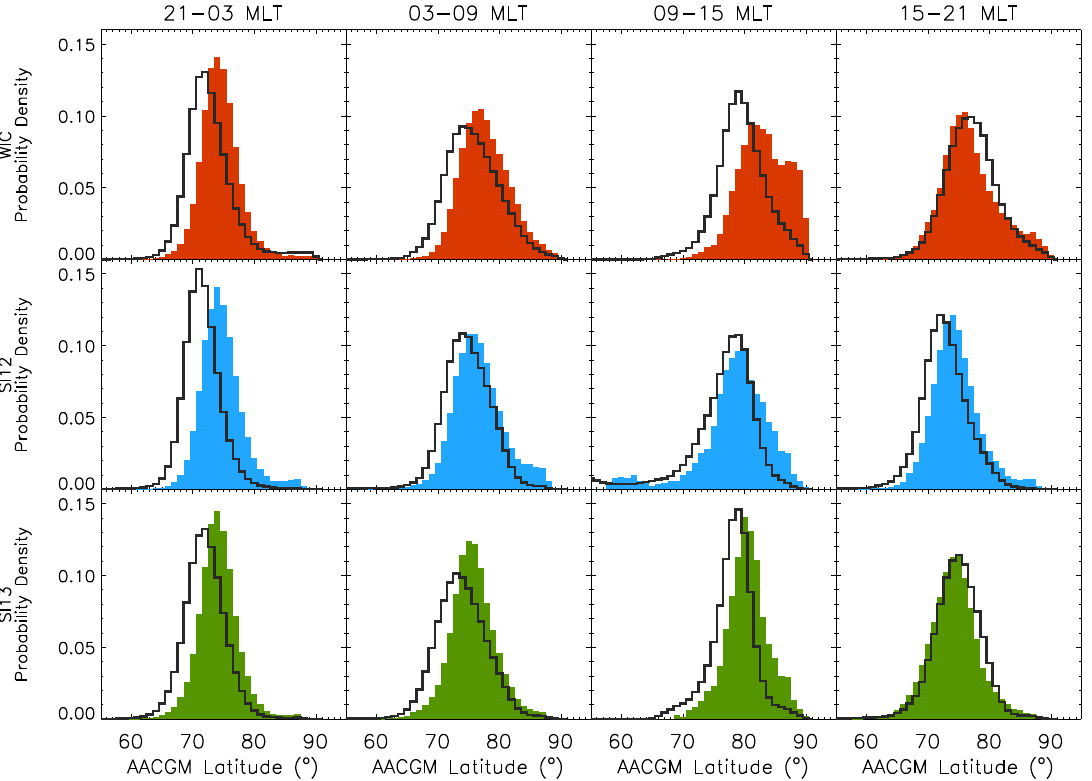
Fig. 6. Probability densities of IMAGE FUV PALBs derived using the method outlined in this paper during May 2000 to August 2002 with a resolution of 1 ◦ . From top to bottom, panels show the densities for PALBs from the WIC, SI12 and SI13 cameras, respectively. From left to right, the panels show the probability densities for nightside, dawnside, dayside, and duskside MLT sectors, respectively. The solid coloured bars show the densities for PALBs derived from double Gaussian ( F d (λ) ) fits to intensity profiles while the black curves show the densities for those derived from single Gaussian ( F s (λ) ) fits to intensity profiles. All successfully located PALBs are